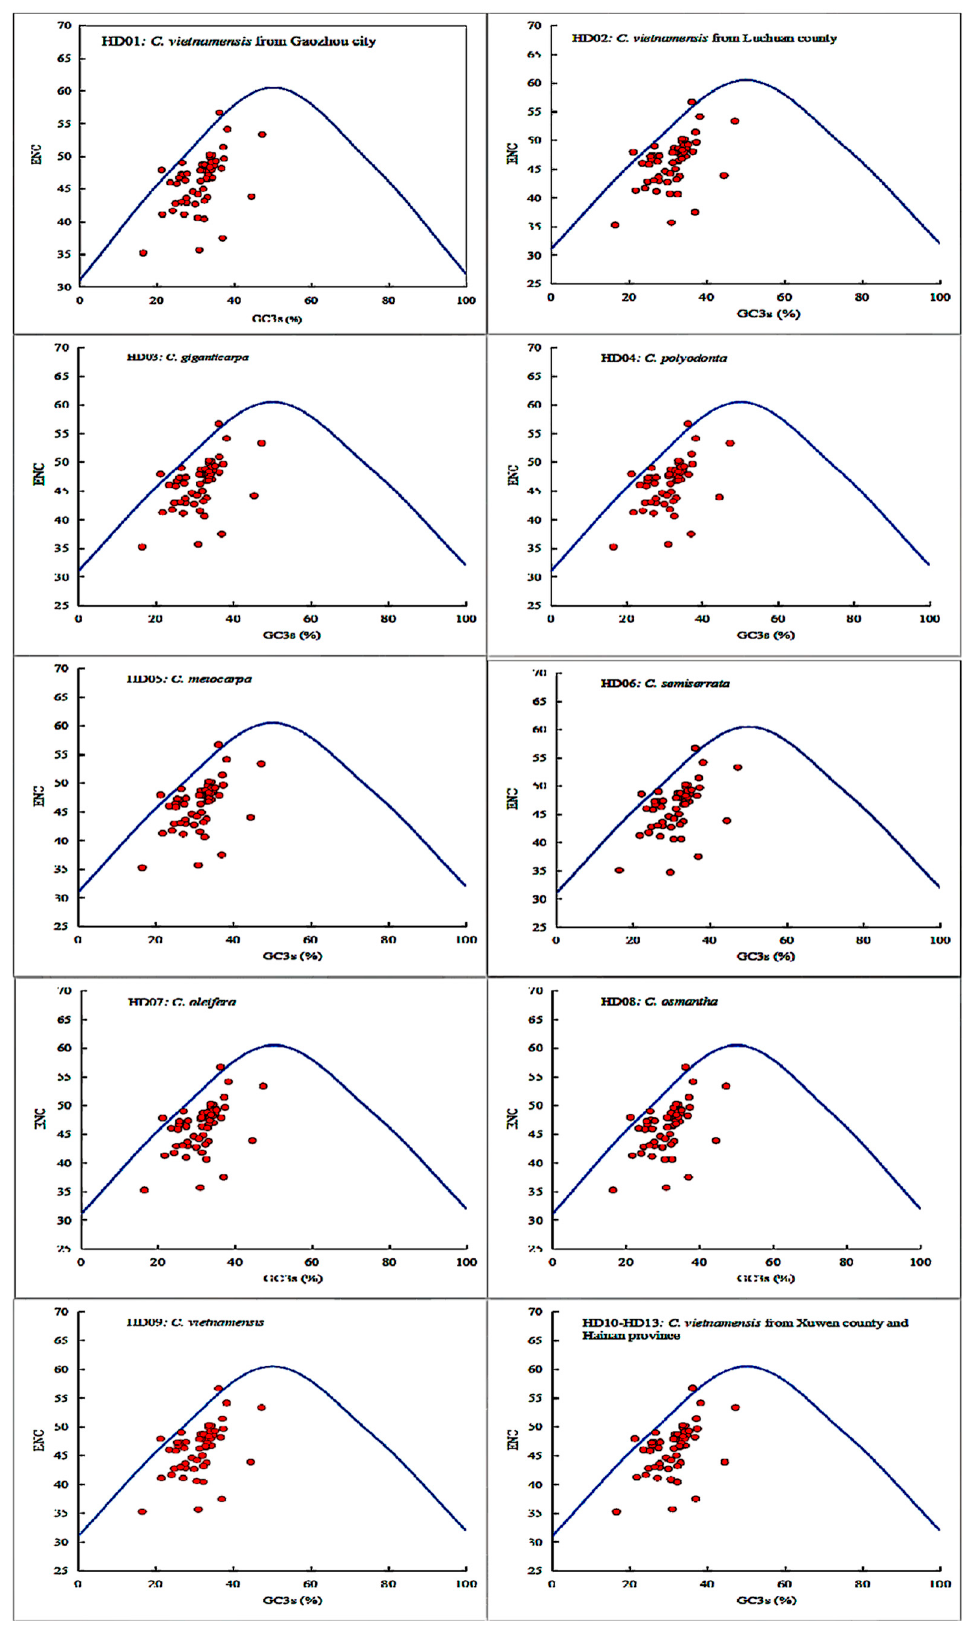
Figure 4. ENC plot analysis of codons in the chloroplast genomes of oil-tea camellia.